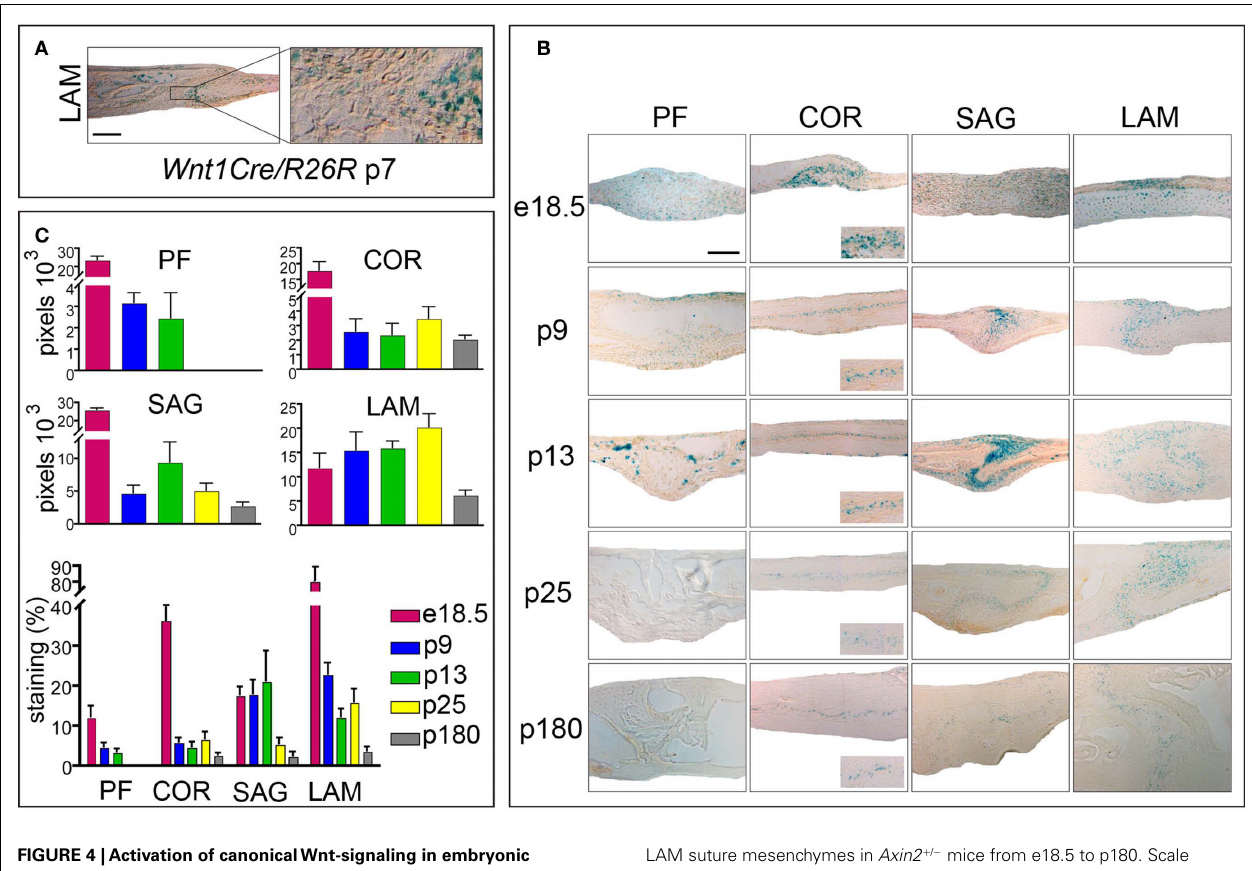
FIGURE 4 |Activation of canonicalWnt-signaling in embryonic and postnatal cranial sutures. (A) Xgal staining of LAM suture harvested from Wnt1Cre/R26R mouse. Xgal staining indicates the neural-crest origin of the LAM suture mesenchyme.The boxed area is enlarged to the right. (B) Xgal staining of PF, COR SAG, and